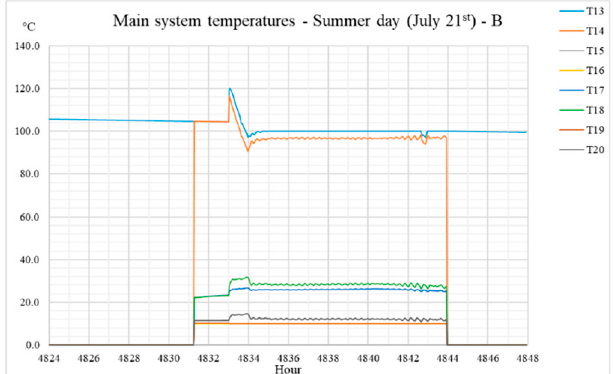
Figure 9. Main system temperatures: summer day (21 July—B).